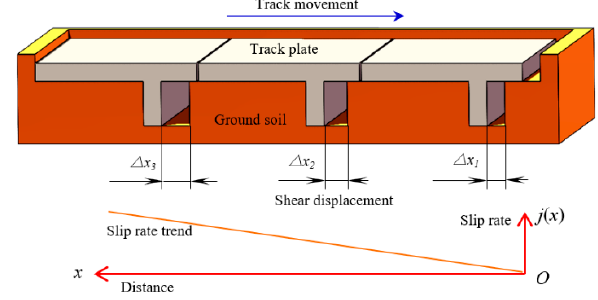
Figure 1. Scheme of slip walking model of the